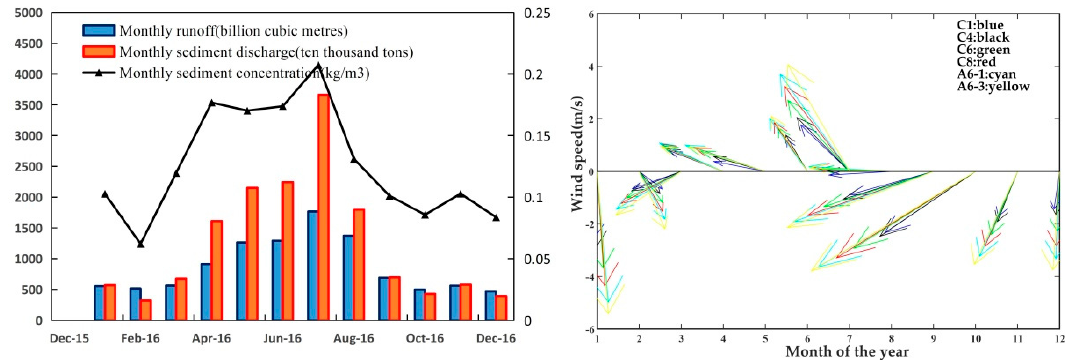
Figure 9. ( a ) Monthly-averaged diluted water discharge and sediment discharge in the Changjiang Estuary. ( b ) Monthly-averaged wind vectors corresponding to the representative stations (C1, C4, C6, C8, A6-3).